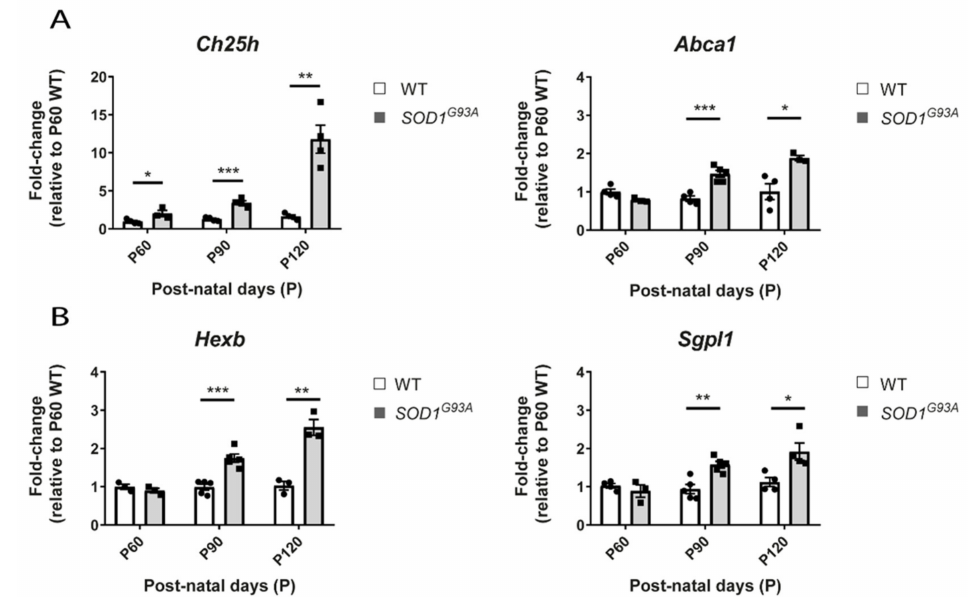
Figure 8. Gene expression level of selected lipid genes by qPCR in the lumbar region of the spinal cord of WT and SOD1 G93A females at different disease stages. Graphs showing the gene expression quantification of several genes by qPCR, in the spinal cord of WT and SOD1 G93A females at 60 days (WT n = 4, SOD1 G93A = 3), at 90 days (WT n = 5, SOD1 G93A = 5), and 120 days of age (WT n = 4, SOD1 G93A = 4). The values are relative to the level of one WT from the P60 group. ( A ). Graphs showing the gene expression quantification of two genes from the cholesterol metabolism pathways, the Ch25h and Abca1 . The data shows the progressive upregulation of Ch25h from P60. ( B ) Graphs showing the gene expression quantification of two genes, Hexb and Sgpl1, from the sphingolipid pathway. The significant upregulation in these genes is observed from P90. Data are represented as the mean +/ − standard error of the mean. p -value * < 0.05, ** < 0.01, and *** <